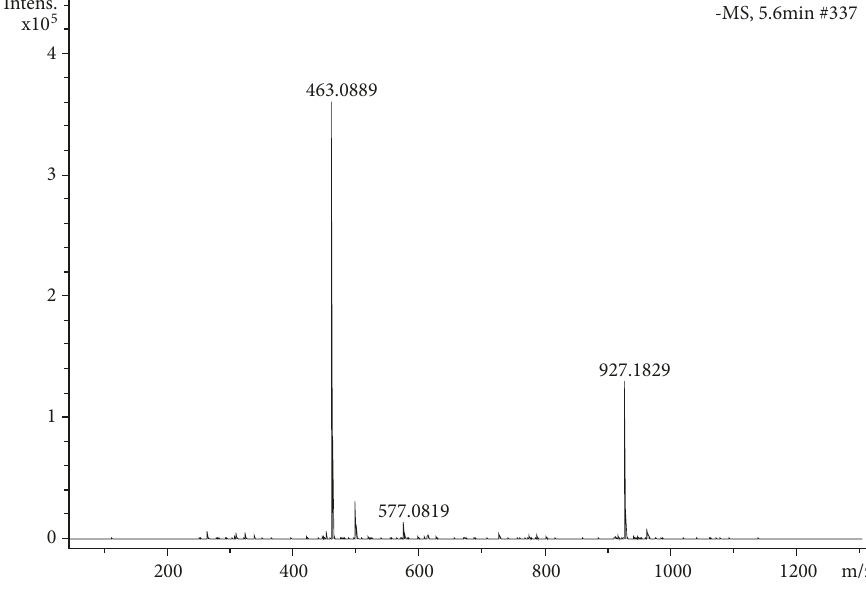
Figure 5: High resolution mass spectra of fraction F4.